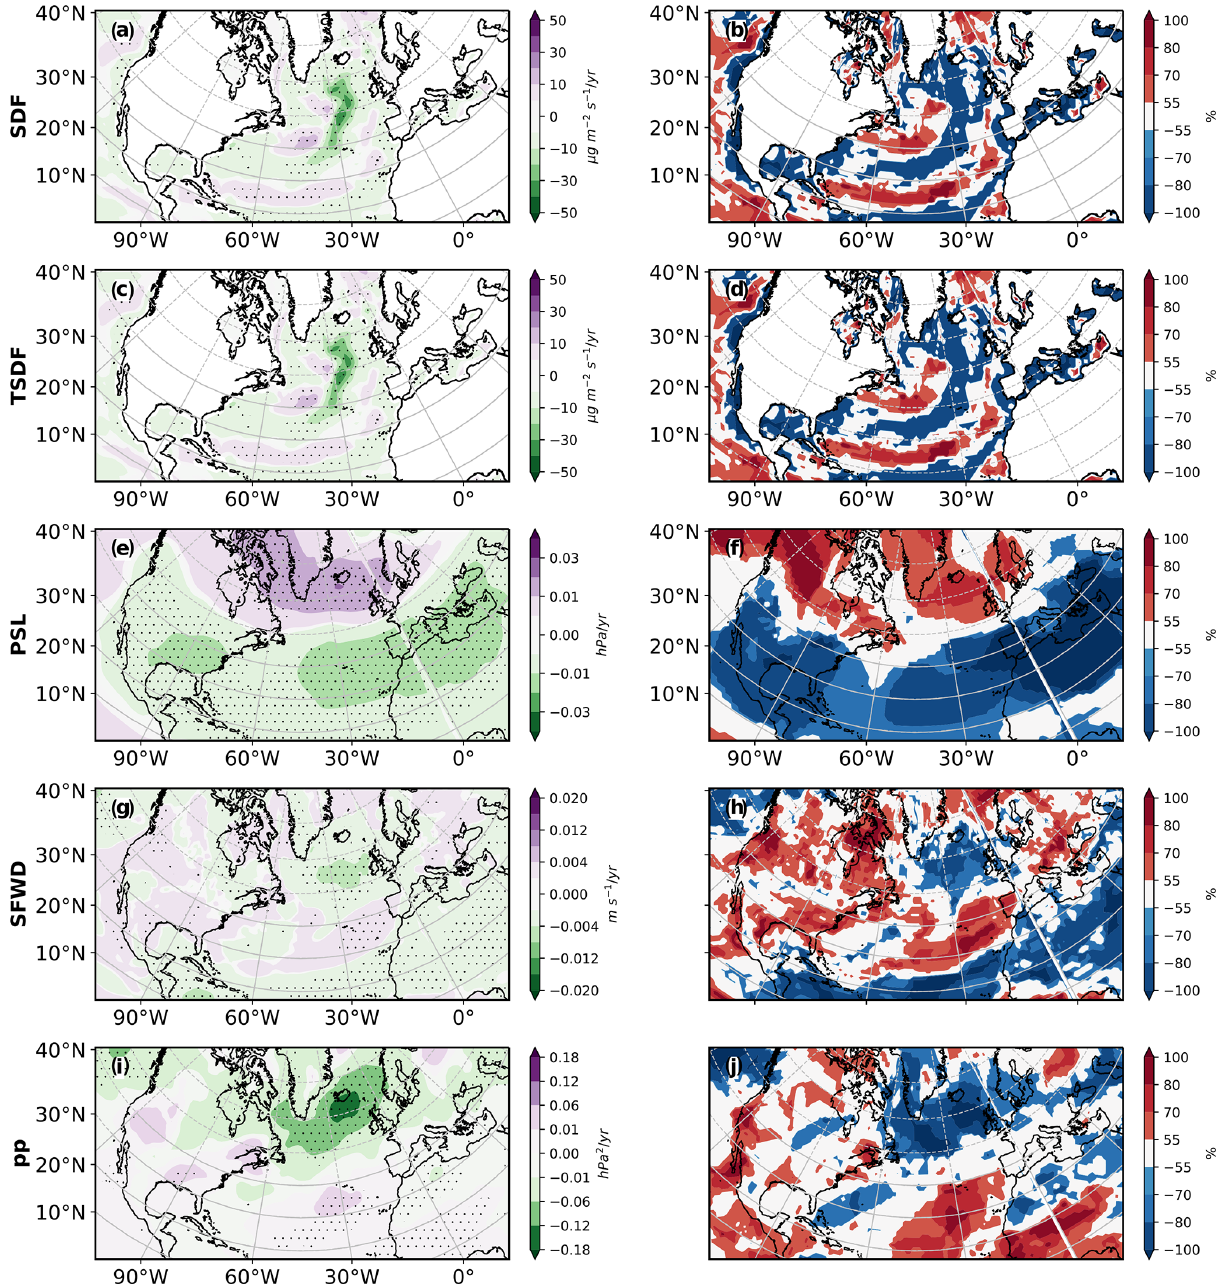
Figure 10. The 1990–2020 annual mean anthropogenic aerosol forcing Coupled Model Intercomparison Project phase 6 ensemble mean trends and model agreement on the sign of the trend: (a, b) surface density flux (SDF), (c, d) thermal SDF (TSDF), (e, f) sea level pressure (PSL), (g, h) surface winds (SFWD), and (i, j) storm track activity (pp). Panels (a, c, e, g, i) show the ensemble mean trend; panels (b, d, f, h, j) show model agreement on the sign of the trend for each model’s ensemble mean. Symbols in (a, c, e, g, i) designate trend significance at the 95% confidence level based on a t test. SDF and TSDF trend units are µgm − 2 s − 1 yr − 1 . PSL, pp, and SFWD trend units are hPayr − 1 , hPa 2 yr − 1 , and ms − 1 yr − 1 , respectively. Trend realization agreement units are %. Red (blue) colors indicate model agreement on a positive (negative)